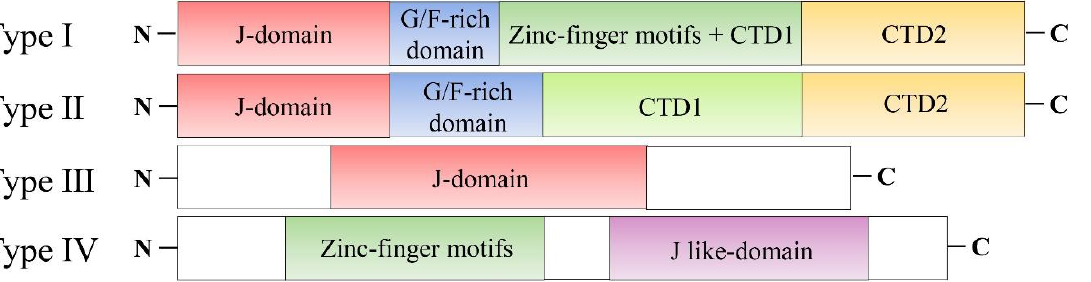
Figure 1. Organization and structures of four types of HSP40 proteins. HSP40s are classified into four subclasses (Type I, Type II, Type III, and Type IV). Type I class contains a J-domain, a glycine and phenylalanine-rich domain (G/F-domain), conserved zinc finger motif, and a client-binding domain (CTD). Type II class includes the J-domain, G/F-domains, and CTD, similar to Type I class, but lacks the zinc-finger domain. The Type III class only has a J-domain and lacks both G/F and zinc-finger domains. In contrast, Type IV class contains a J-like domain and conserved zinc finger motif.